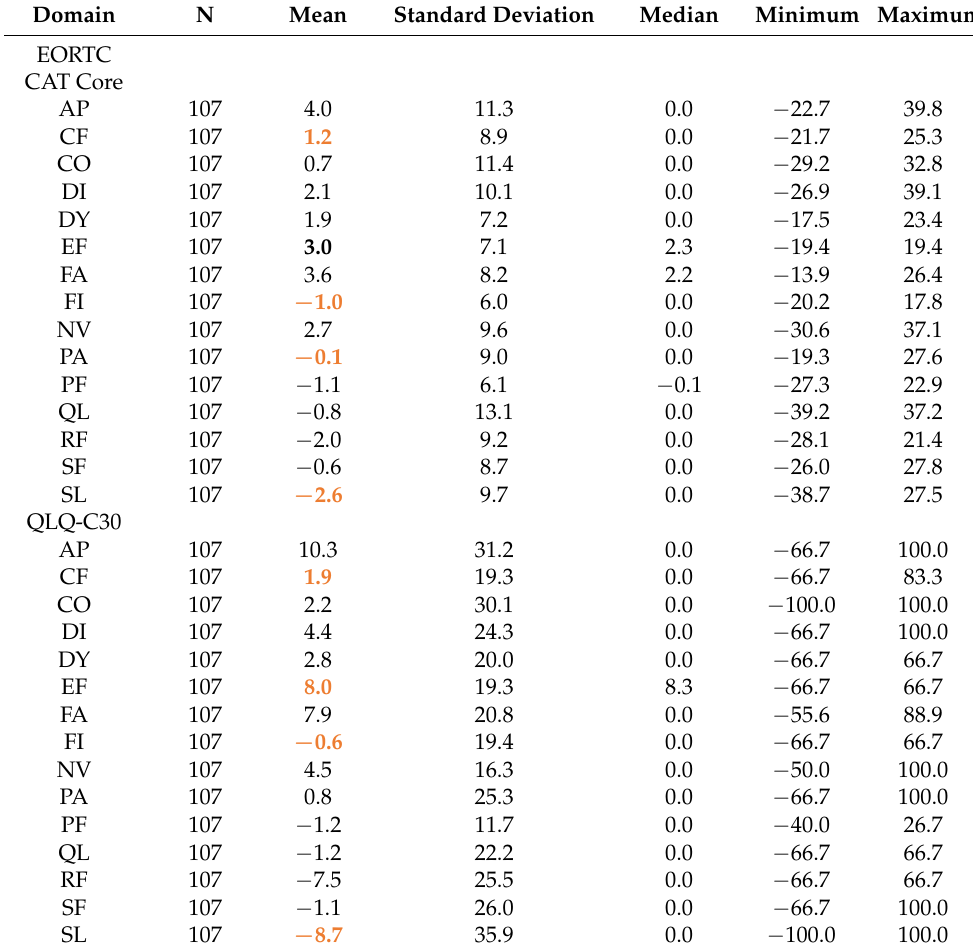
Table 3. Differences between follow-up (T1) and baseline (T0) scores of the EORTC CAT Core and QLQ-C30 for Brazilian